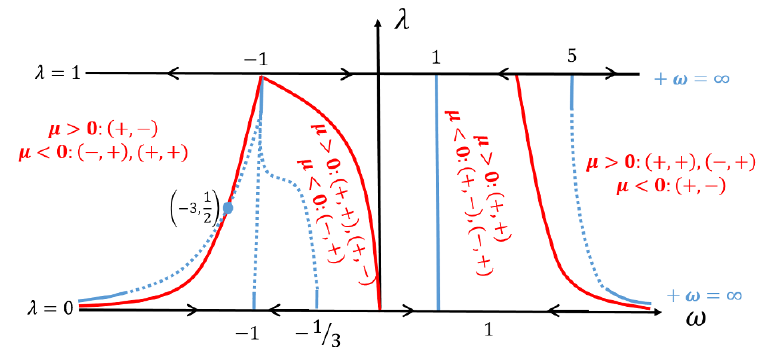
Figure 14. Superimposing the phase diagram on the RG (cid:13)ow